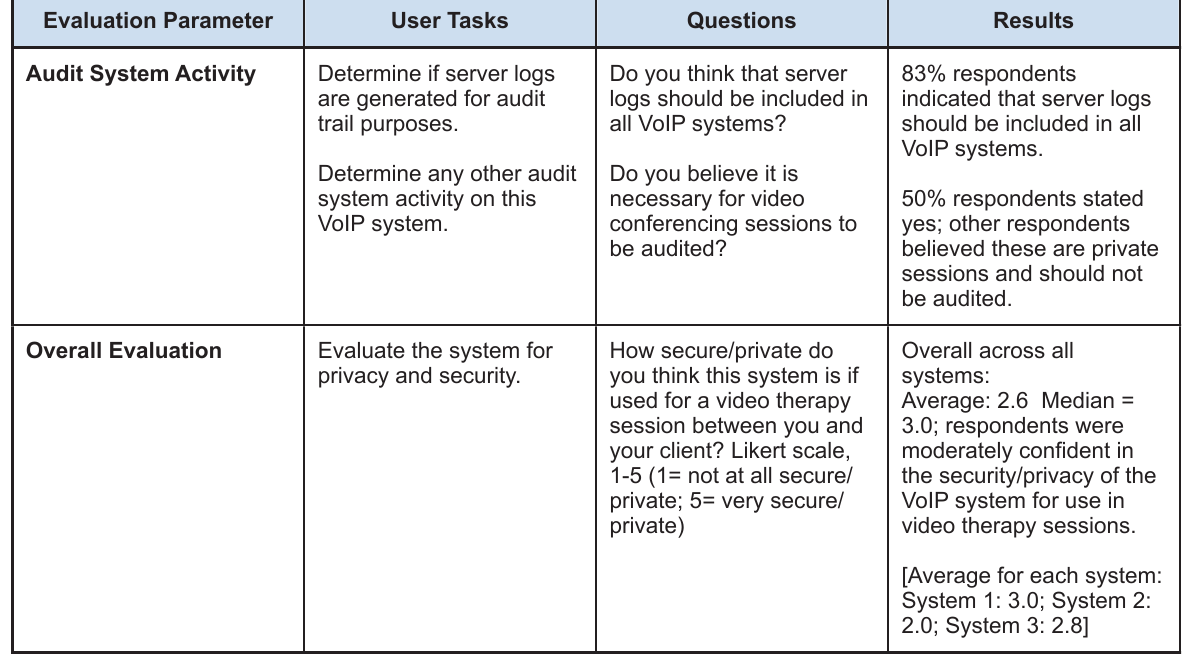
Table 2 : Evaluation Protocol and Results